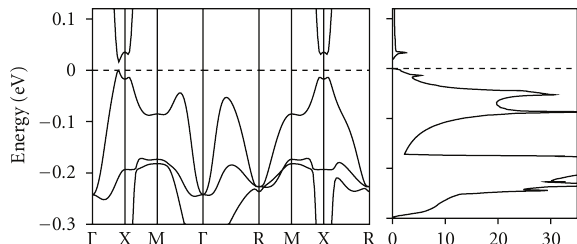
Figure 53: Expanded view of the energy band structure and total DOS (in states/(unit cell eV)) of SmB 6 for Sm 2+ ions calculated in LSDA+ U approximations